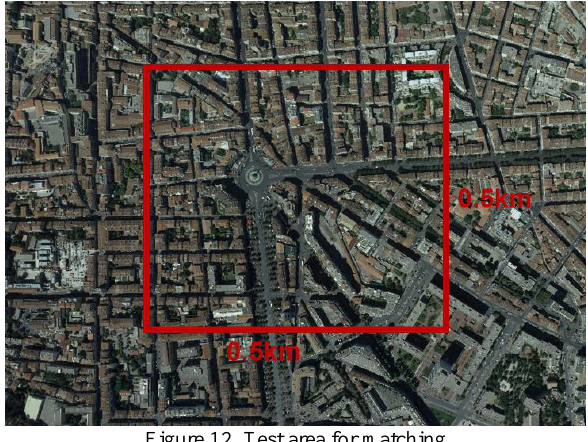
Figure 12. Test area for matching